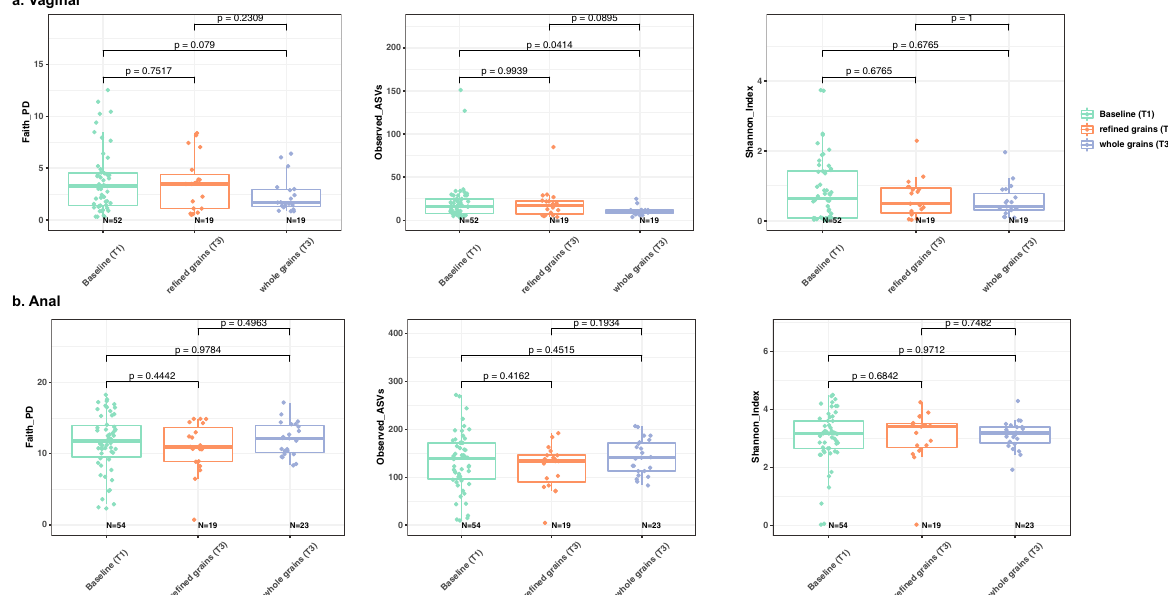
Figure 1. Alpha diversity in the vaginal and anal microbiota of 103 mothers. Faith PD, Observed ASVs, and Shannon index was presented respectively, Kruskal–Wallis test performed between the three groups. ( a ) Vaginal microbiome. ( b ) Anal